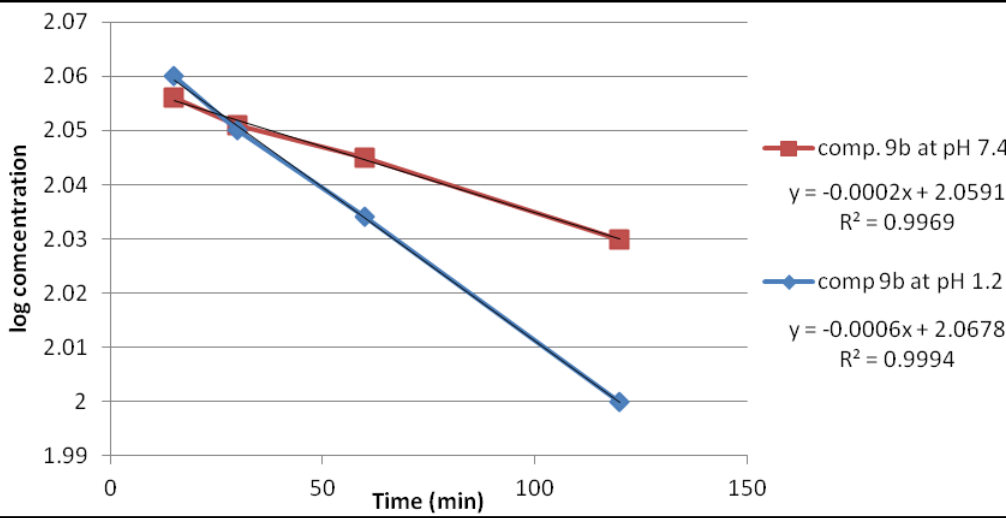
Figure 3. The hydrolysis rate of compound 9b at different pH